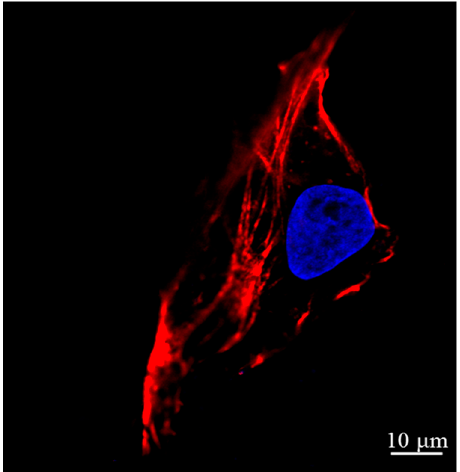
Figure 5. Immunofluorescence image of a single cell at the interphase. The F-actin and the nucleus were stained with Phalloidin (red) and DAPI (blue), respectively.